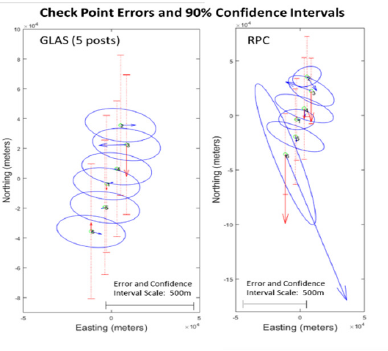
Figure obtained from custom MATLAB code Figure 7. GLAS (5 posts) and RPC ChkP errors and 90%